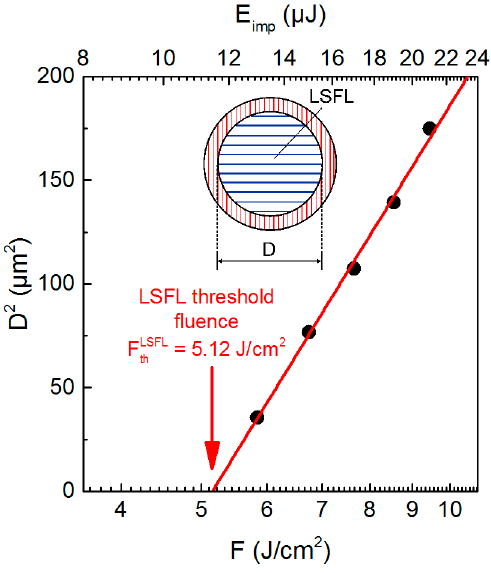
Figure 4. Evaluation of the threshold of low-spatial frequency LIPSS (LSFL) formation upon irradiation with linearly polarized fs-laser pulses ( N = 5) using the method proposed by Liu [34]. Moreover, the value measured for F thLSFL continuously decreases from its initial value of 5.12